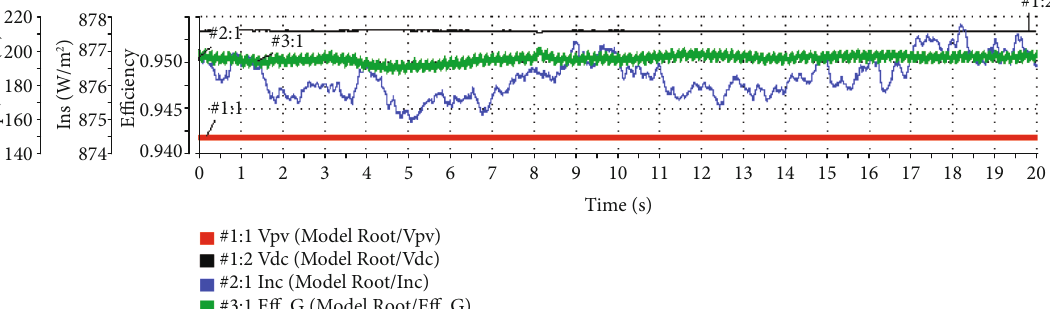
Figure 19: Steady-state voltage characteristics.